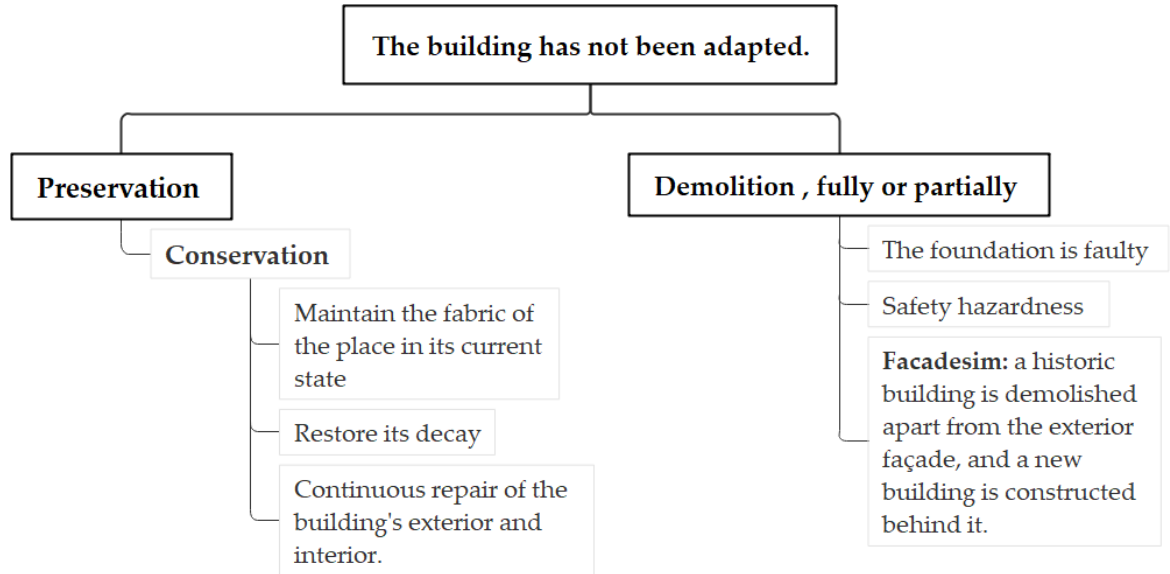
Figure 4. Breakdown of the building adaptation terminologies for a building that has not been recently refurbished.